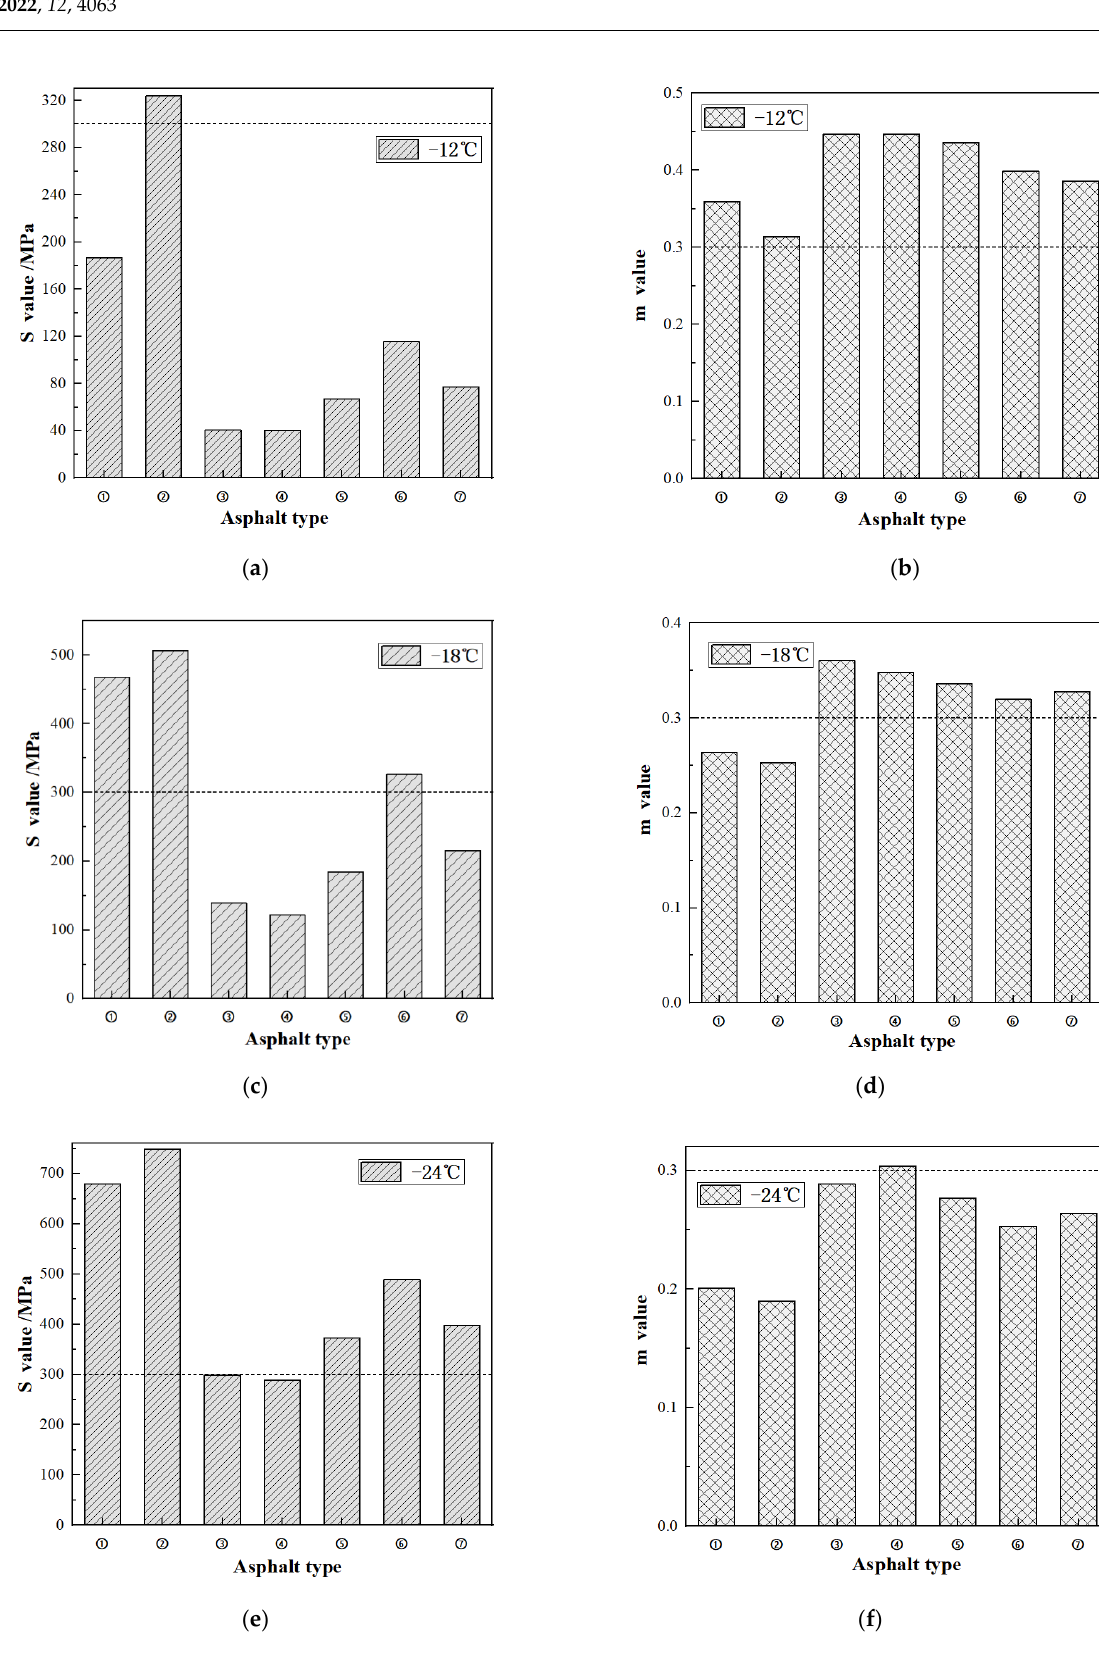
Figure 6. BBR test results of the PAV aged asphalt at different temperatures; ( a ) S value of each asphalt binder at − 12 ◦ C; ( b ) m value of each asphalt binder at − 12 ◦ C; ( c ) S value of each asphalt binder at − 18 ◦ C; ( d ) m value of each asphalt binder at − 18 ◦ C; ( e ) S value of each asphalt binder at − 24 ◦ C; ( f ) m value of each asphalt binder at − 24 ◦